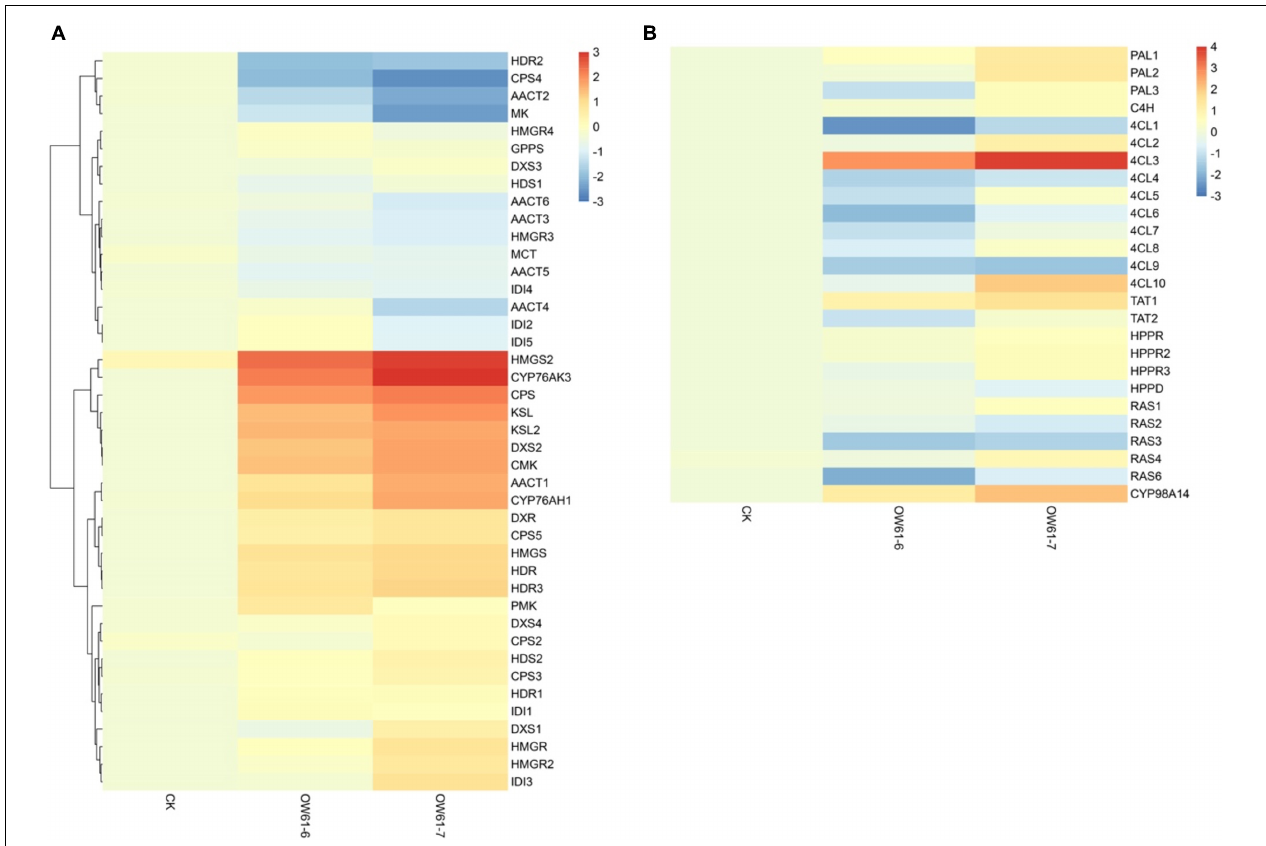
FIGURE 5 | Genes expression in the biosynthesis of tanshinone and salvianolic acid in the S. miltiorrhiza hairy roots. (A) Gene expression of tanshinones biosynthesis in S. miltiorrhiza hairy roots. (B) Gene expression of phenolic acids biosynthesis in S. miltiorrhiza hairy roots. “CK” means the control group. The data were standardized, and the hierarchical clustering method was complete in R